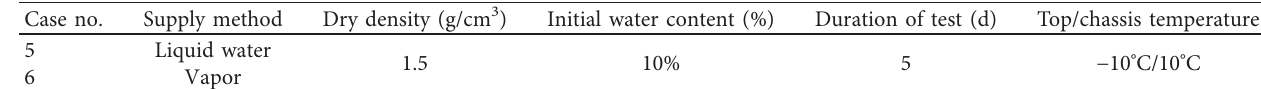
Table 2: Influence of water supply method for